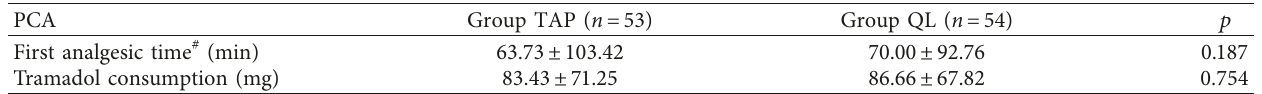
Table 3: Comparison of patient-controlled analgesia in groups.